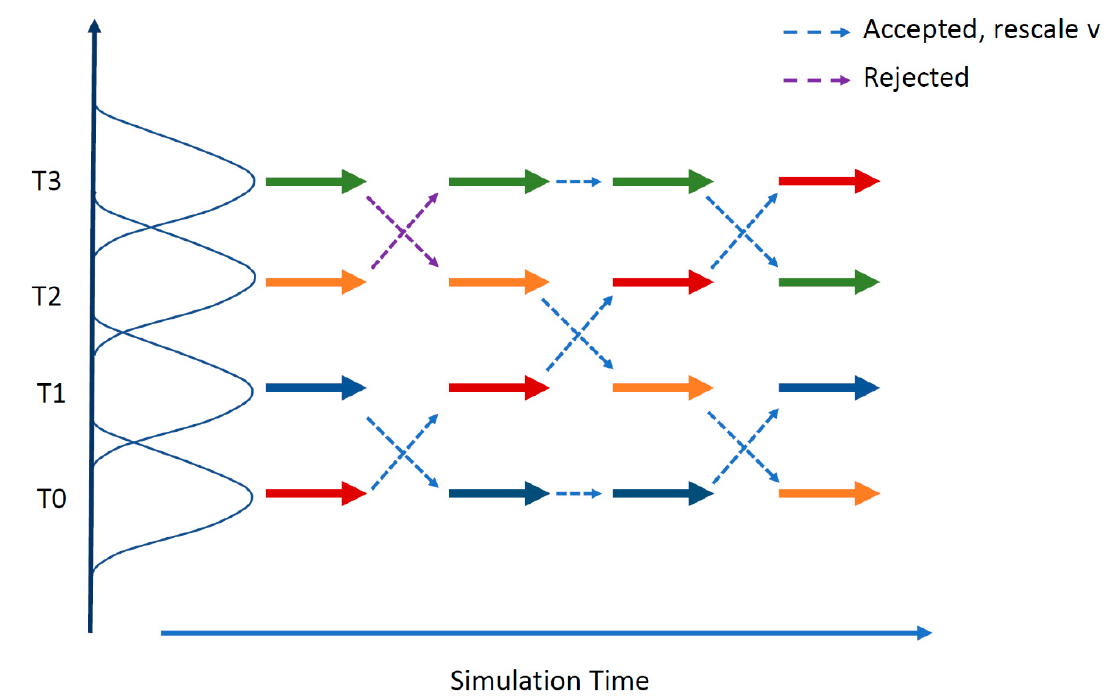
Figure 5. The replica exchange molecular dynamics (REMD) method. REMD combines multiple MD simulations with the Monte-Carlo-based replica exchange algorithm [152,153]. Several replicas of the same system are simulated in parallel at different temperatures. At specified intervals, replicas with neighboring temperatures are exchanged with the Boltzmann weighted Metropolis criterion. After a successful temperature exchange, velocities are rescaled to those expected in the new temperature condition. Successful swapping between replicas happens when there is some overlap between the potential energy of neighboring replicas over the course of a simulation.